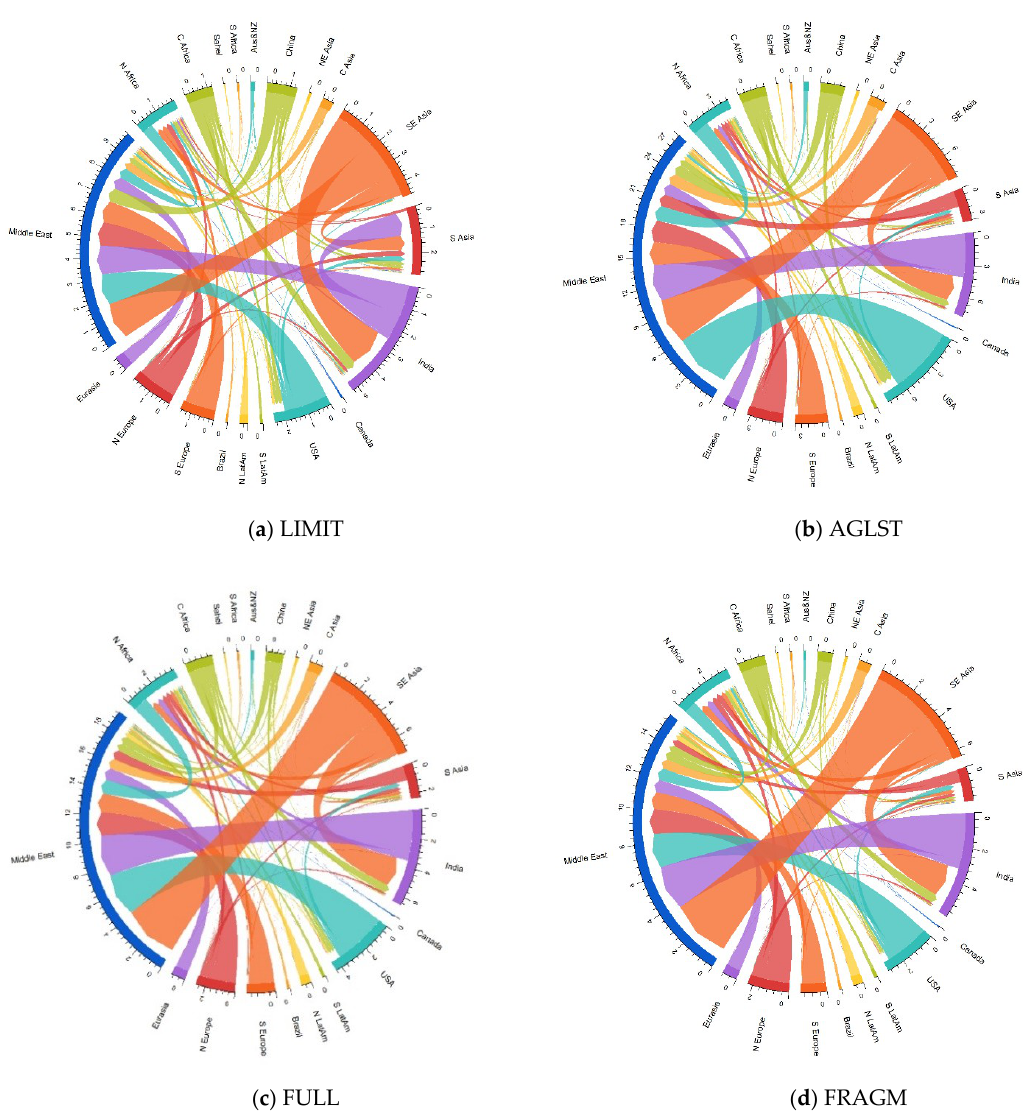
Figure 9. Changes in virtual water trade flows of crops—( a – d ) net values by trading pair (in km 3 ) and by allocation method.